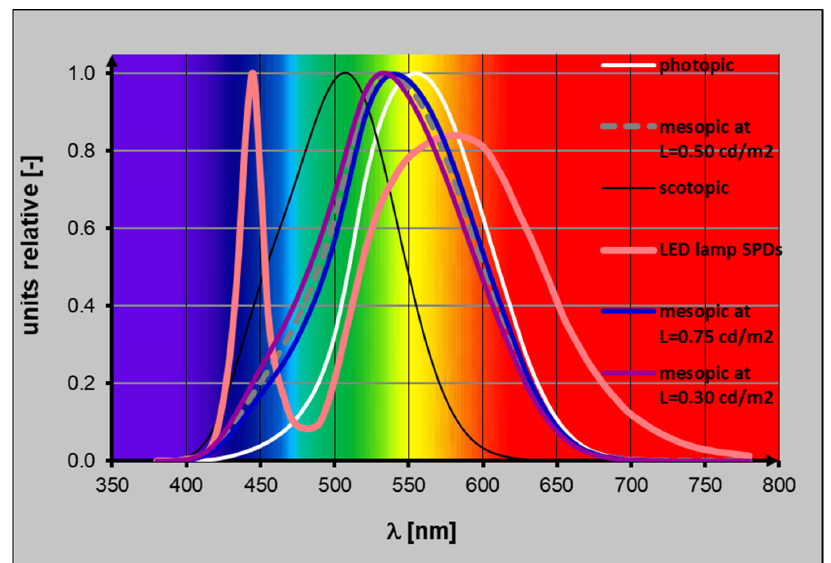
Figure 9. Spectral distribution of the LED_26W road lighting luminaire (pink line) and sensitivity curves of the human eye under mesopic conditions for LED_26W lighting for luminance 0.30 cd/m 2 (purple curve); 0.50 cd/m 2 (dashed grey) and 0.75 cd/m 2 (navy blue), as well as spectral sensitivity of the eye under photopic conditions (white line) and under scotopic conditions (black line).